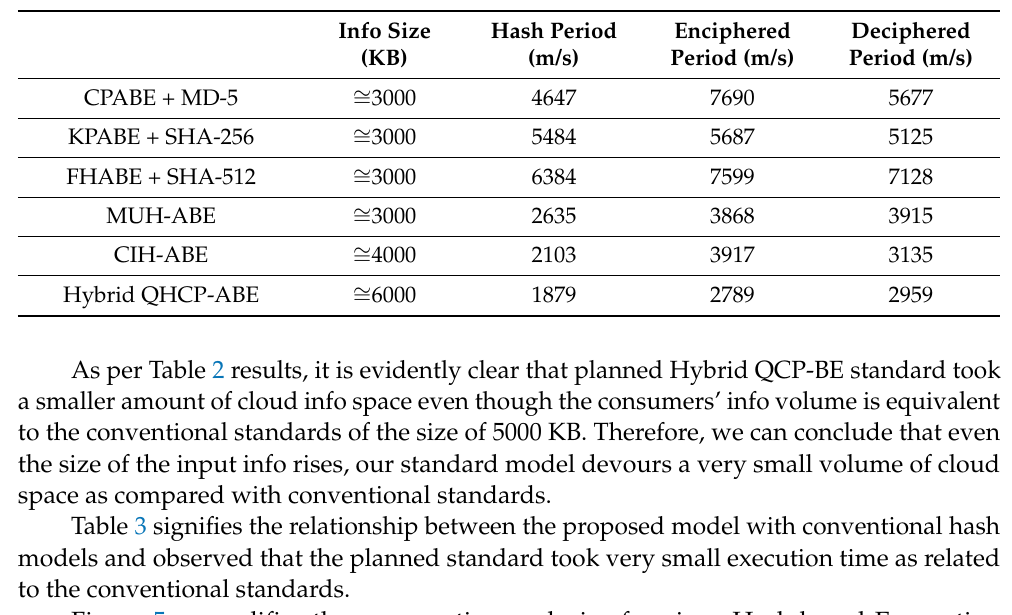
Table 1. Analysis of different Hash ‐ based Encryption Techniques.